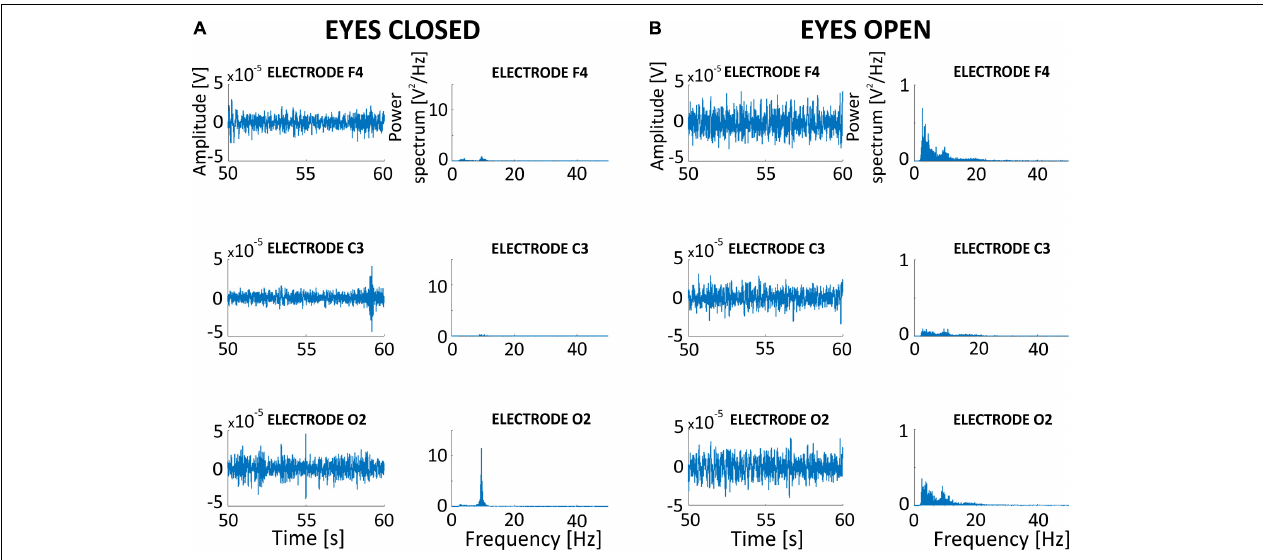
FIGURE 10 | Effects of SMA filtration on EEG signal recorded during 10 Hz sinusoidal toACS from three different electrodes (F4, C3, and O2) during both eyes open (A) and eyes closed (B) conditions. EEG signals were filtered with a moving window that consisted of 600 1-period